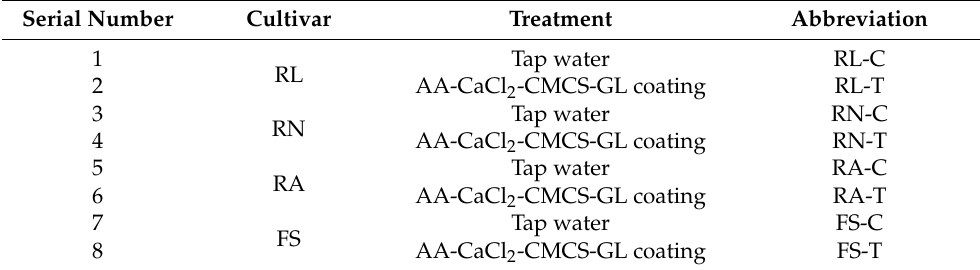
Table 2. The four cultivars of sweet cherry with or without the treatment of AA-CaCl 2 -CMCS-GL coating (2